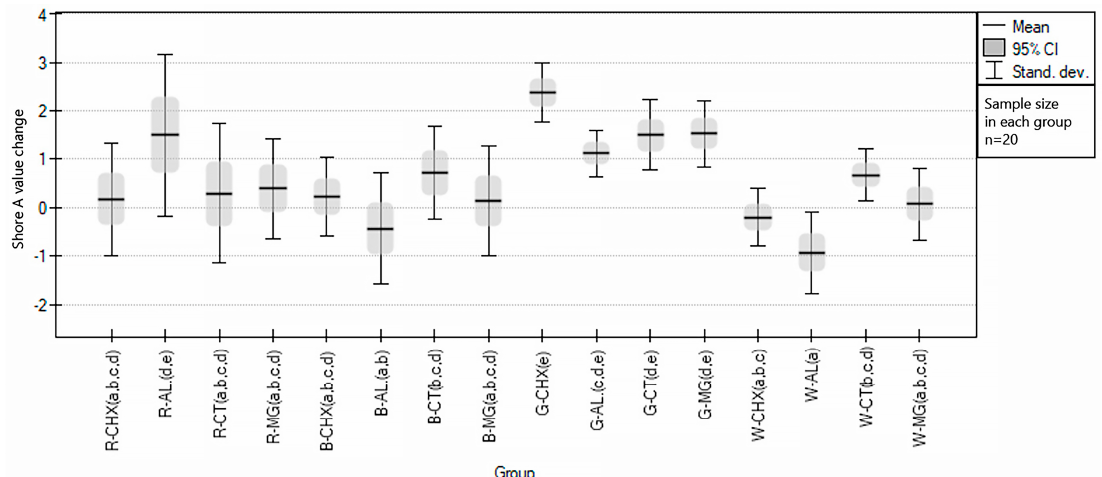
Figure 4. Graphical representation of the results of statistical analysis of the hardness of EVA samples under the influence of disinfecting materials, divided into groups. The same lowercase letters in brackets after the group code indicate homogeneity between the groups in post-hoc Sheffe testing.